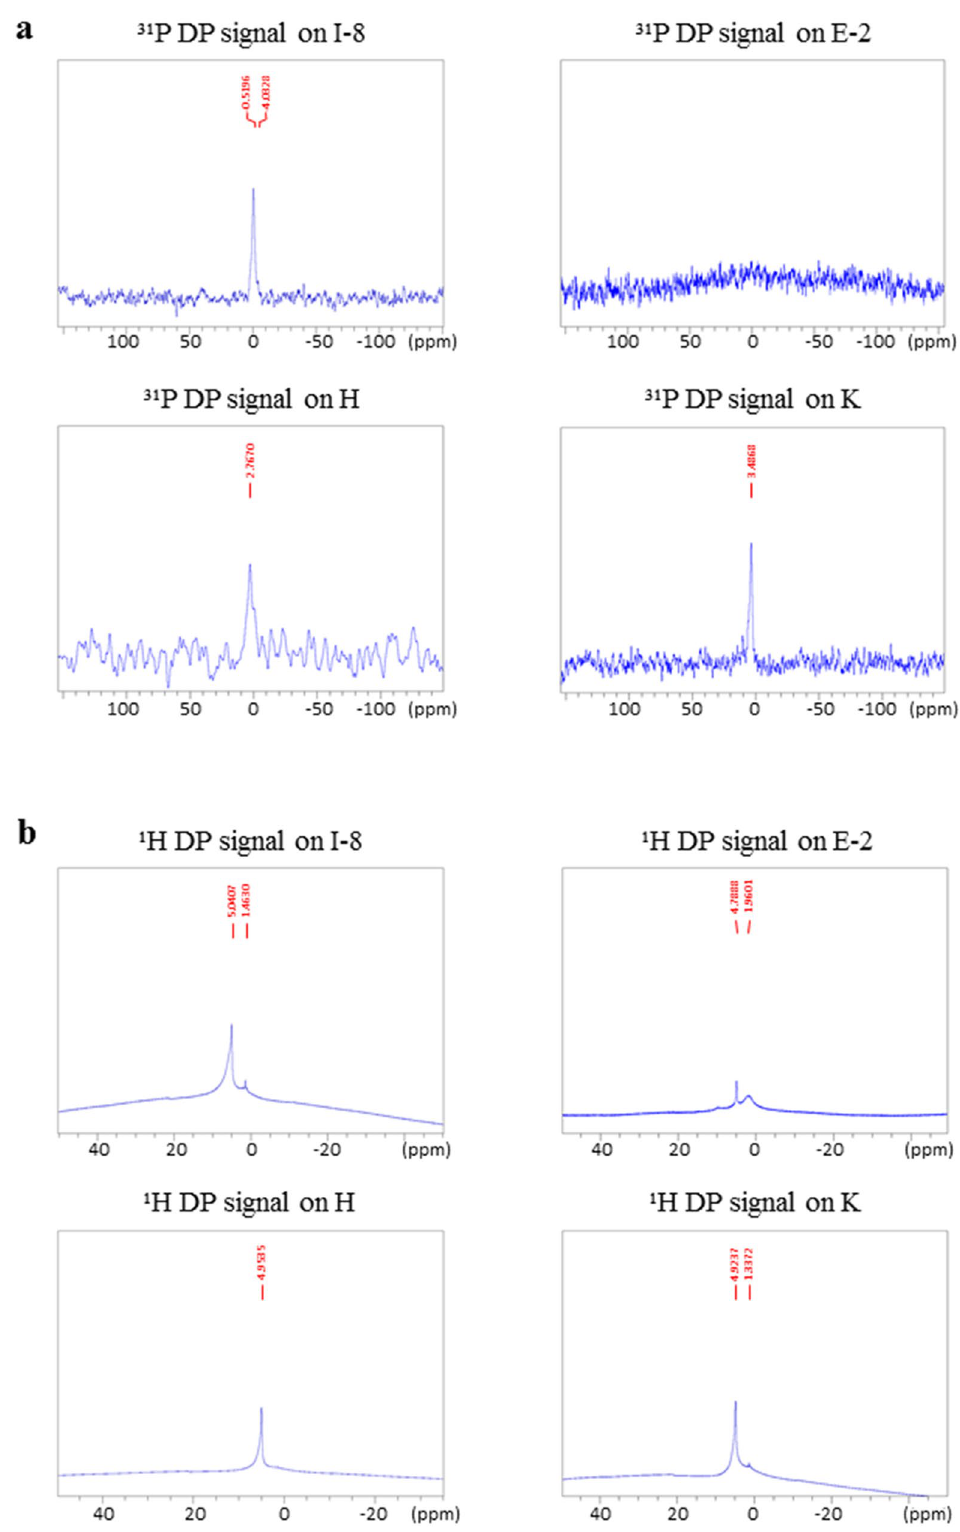
Figure 4. Solid state NMR results: I-8 representative sample from Te’omim cave, Israel; E-2 representative sample from Egypt; H from Herodium bathtub; K from Kypros bathtub. ( a ) 31 P NMR data. ( b ) 1 H NMR